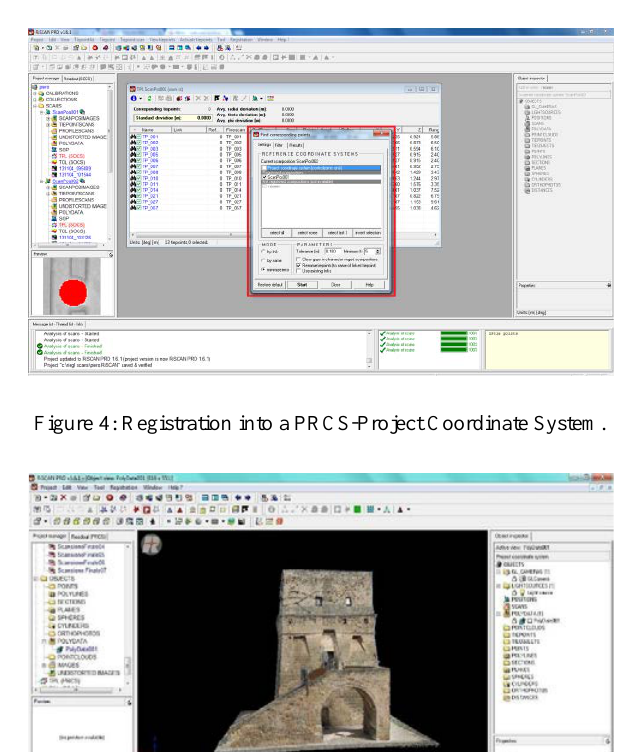
Figure 3: “Find reflectors” function.